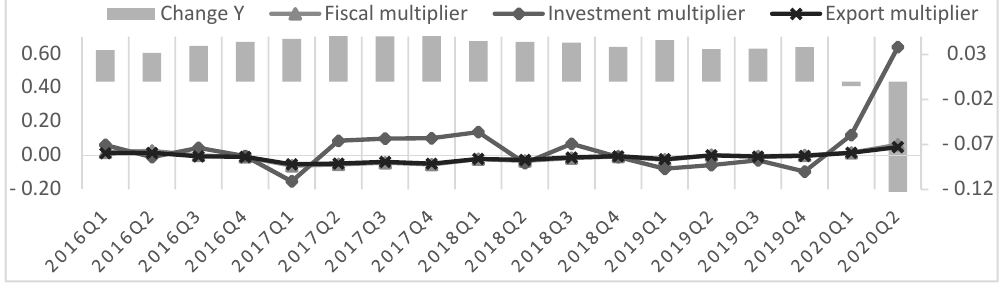
Figure 16. Changes in autonomous expenditure multipliers and GDP—Portugal, own work, source: Eurostat.